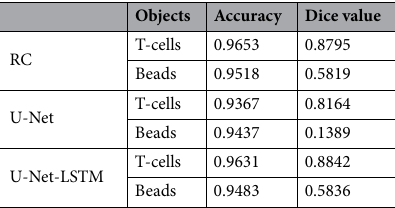
Objects Accuracy Dice value